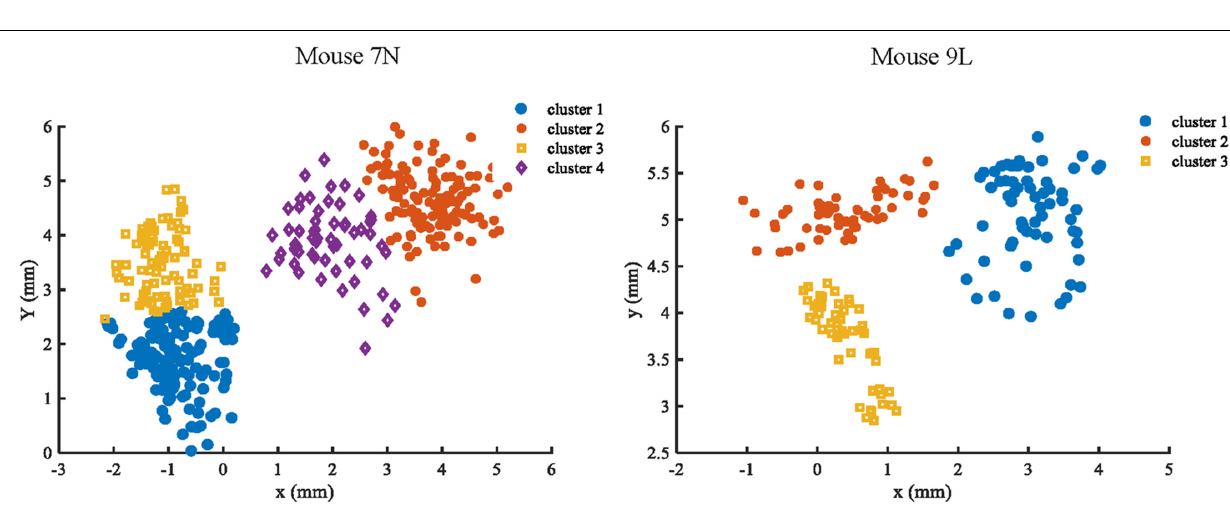
reach location is 1 in 4, or 25% for mouse 7N and 1 in 3, or